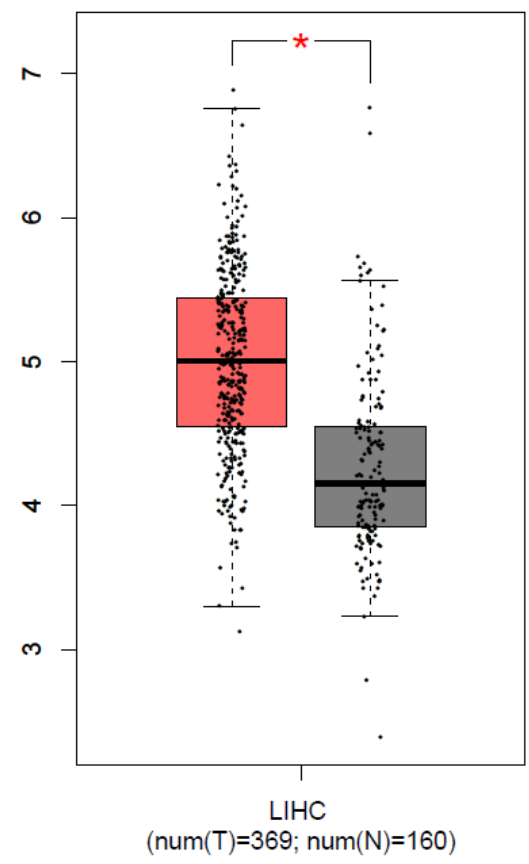
Figure 1: B3GAT3 was up-regulated in human liver cancer. GEPIA was used for the analysis of B3GAT3 expression, and the boxplot was plotted. The red and gray boxes represent LIHC and normal liver tissues respectively. * P <0.05 compared with N. N, normal tissues. T, tumor